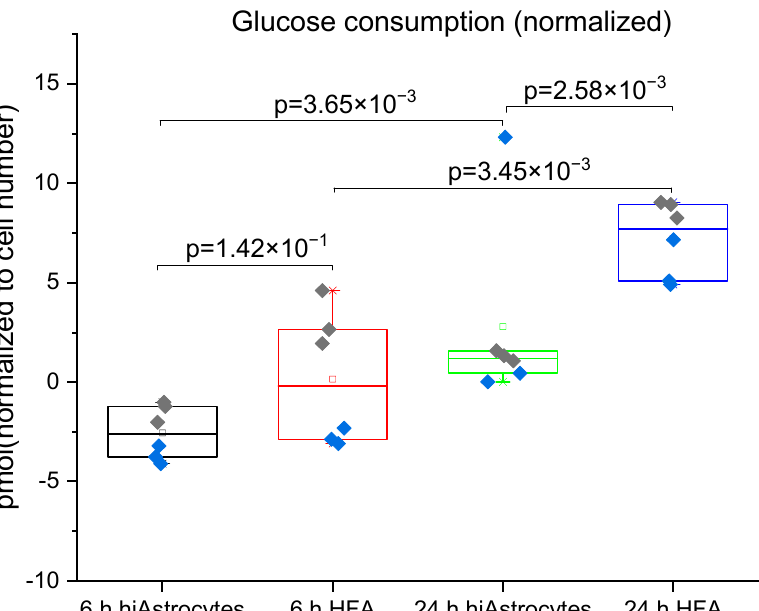
6 h hiAstrocytes 6 h HFA Figure 5. Glucose consumption measured for hiAstrocytes and HFA using a flow-based biosensor: Glucose consumption of hiAstrocytes and HFA after 6 h and 24 h treatment with defined media. Data were normalized to estimated cell numbers and relative DNA content of the samples at 24 h. Data are presented both as a box indicating the 25th–75th percentile, including a median line with 95% CI for the whiskers, with the addition of individual data points where colors represent independent experimental rounds. All corresponding p-values are presented in the graph, with a significance cutoff of 1 × 10 − 2 to correct for multiple comparisons. The baseline drift of the sensor proves to be the limiting factor for the high-concentration analyte glucose, evidenced by negative values at 6h.